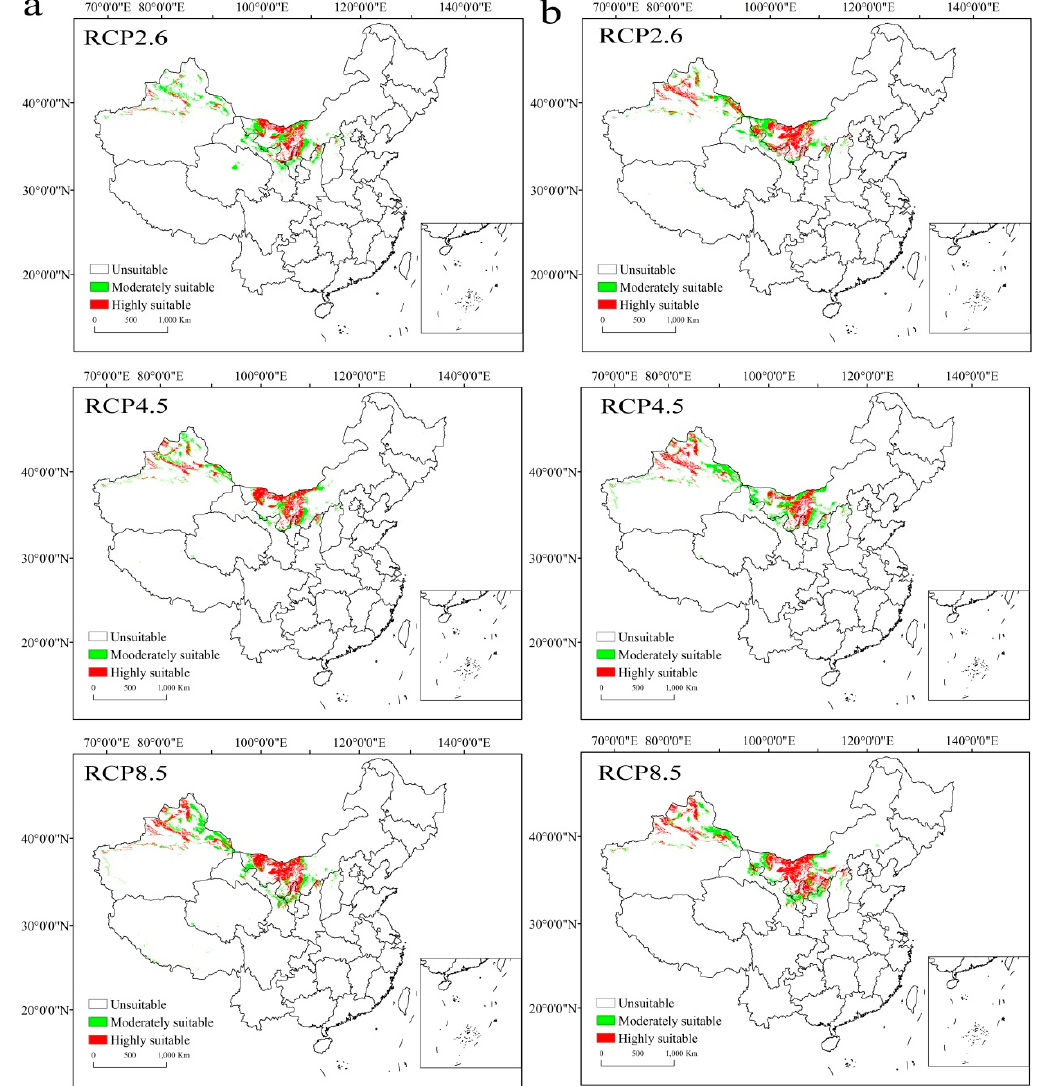
Figure 5. Comprehensive habitat suitability of C. deserticola under di ff erent RCPs in 2050s ( a ), and 2070s ( b ).